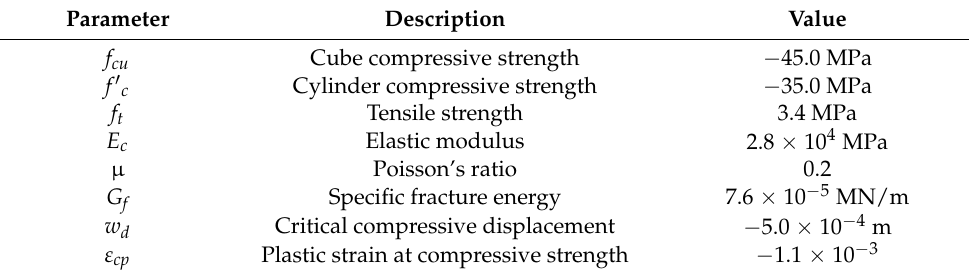
Table 6. Input data for the cementitious matrix used with carbon.